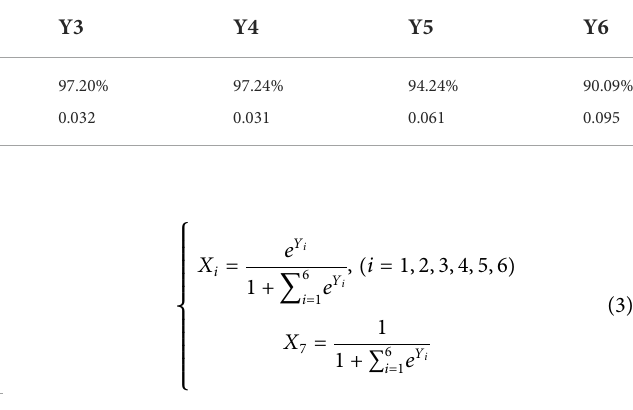
TABLE 5 Residual test and posterior test of grey prediction model.